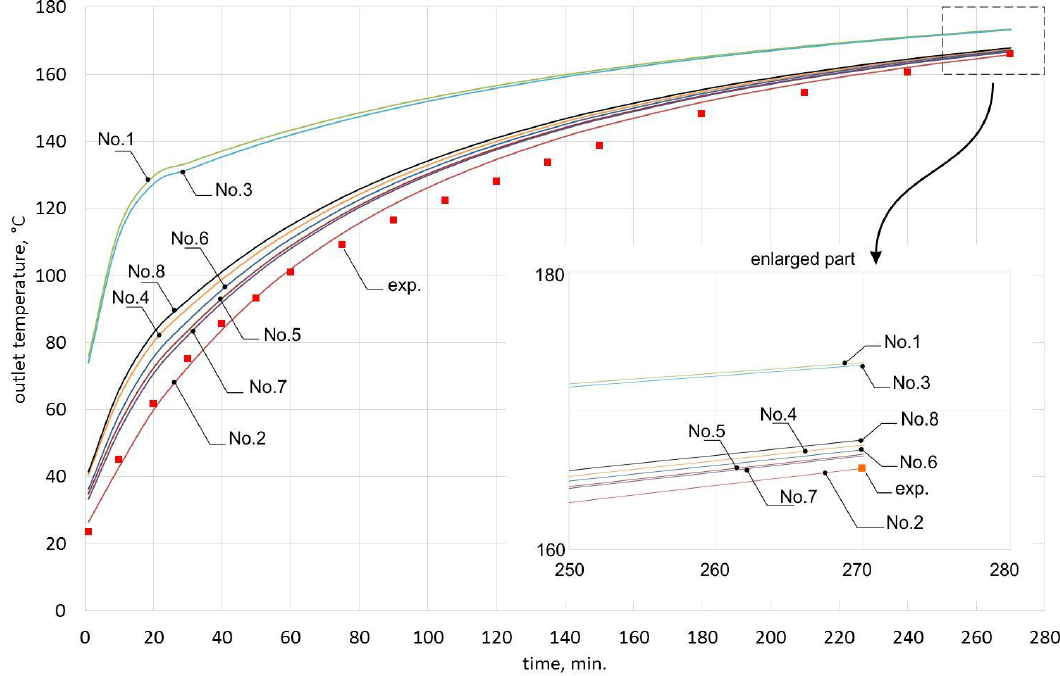
Figure 7. Outlet temperature for the airflow of 0.0068 m 3 /s, for each of the dimensionless equations from Table 2.